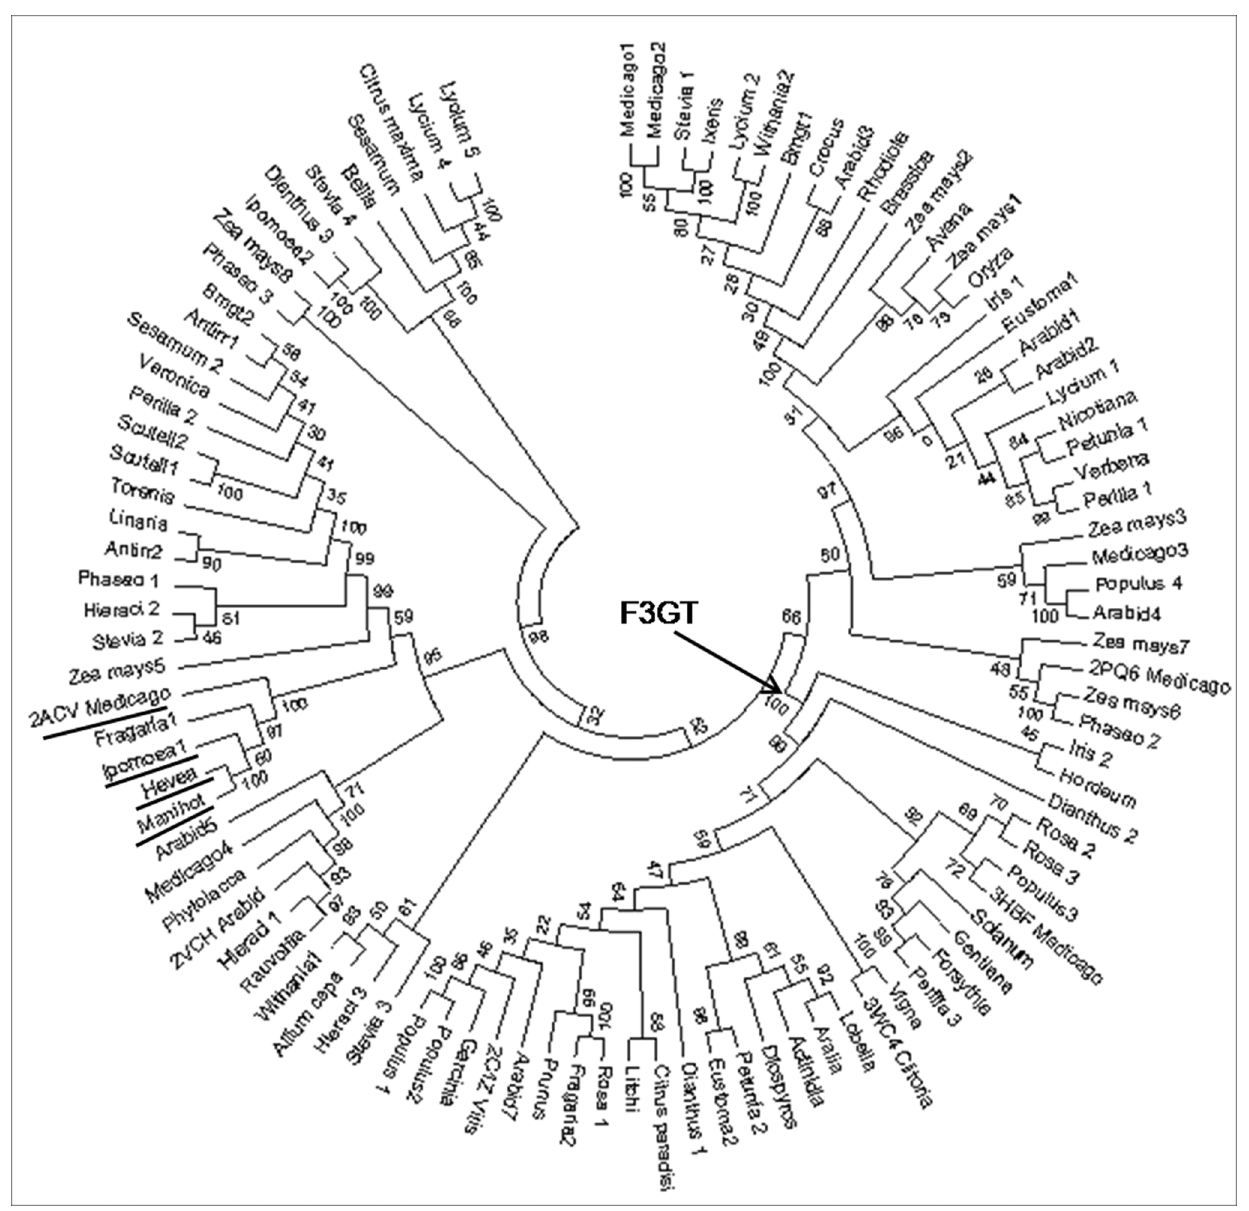
Figure 3. Phylogenetic tree of 101 UGTs. Dendrogram of 101 UGT protein sequences shows distinct clusters of F3GT members marked with an arrow. The underlined taxon names are annotated to be flavonoid-3-OH glycosyltransferases and they form a separate clade.